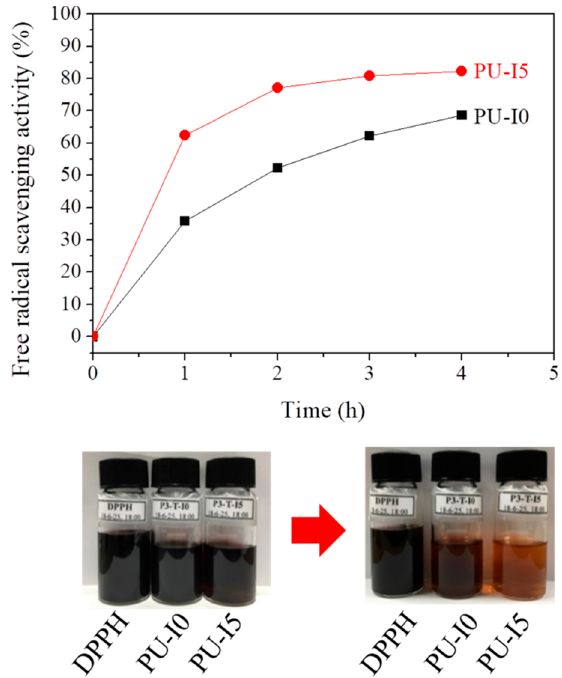
Figure 11. Free radical scavenging activity of PU films with or without ISB.